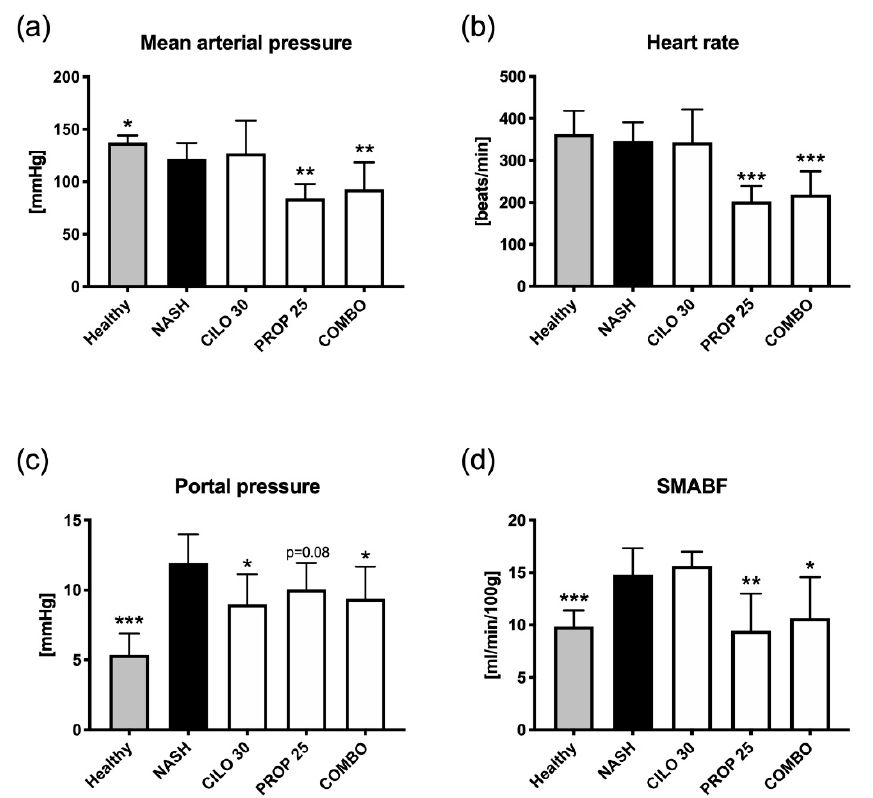
Figure 4. Effects on systemic and hepatic hemodynamics after treatment with cilofexor ± propranolol. ( a ) Mean arterial pressure was decreased in NASH rats and further reduced by treatment with propranolol. Cilofexor (CILO) caused no change in mean arterial pressure. ( b ) Heart rate remained unchanged in NASH animals and also after treatment with cilofexor, whereas propranolol (PROP) decelerated the heart significantly. ( c ) Portal pressure was significantly increased in NASH rats. Cilofexor decreased portal pressure alone and in combination with propranolol (COMBO). However, in NASH rats receiving solely propranolol, only a trend towards decreased portal pressure was observed. ( d ) Superior mesenteric blood flow (SMABF) was increased in NASH animals, and this was not changed by cilofexor. Propranolol treatment reduced SMABF to mean values comparable to the NASH-diseased control group. * p < 0.05, ** p < 0.01, *** p < 0.001 vs. NASH (14-week